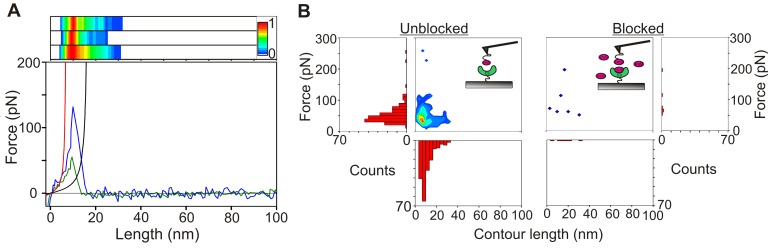
Quantifying unbinding forces for E9:immunity protein complexes.(A) Bottom: typical force extension profiles for E9:Im9 dissociation for 3:81 (green) and 320–66:81 (blue) both taken with retraction velocities of 1,000 nms−1. Solid black line corresponds to a worm-like chain (WLC) with a persistence length of 0.4 nm and a contour length of 17.96 nm for an interaction between Im9 immobilised via linkers to the tip apex and E9 immobilised to a substrate via linkers directly below the tip. Solid red line shows a WLC with the most probable contour length after modelling for tip effects (Text S1) where the maximum expected contour length used in the simulation is 17.96 nm. Top: frequency distribution of fitted contour lengths of unbinding events from unfiltered data. The normalised frequency of a particular contour length is displayed as a colour scale from 0 (white) to 1 (red). Each plot (E9:Im9 3:81 for a dataset accumulated at 500, 5,000, or all retraction velocities, top to bottom) shows a single maximum centred on 10 nm. (B) Contour plot and force and contour length frequency histograms of unfiltered data showing that the force and extension at which E9:Im9 unbinding occurs are highly correlated and yield a single unbinding event. Addition of excess Im9 to the solution during measurement ablates these correlated events.